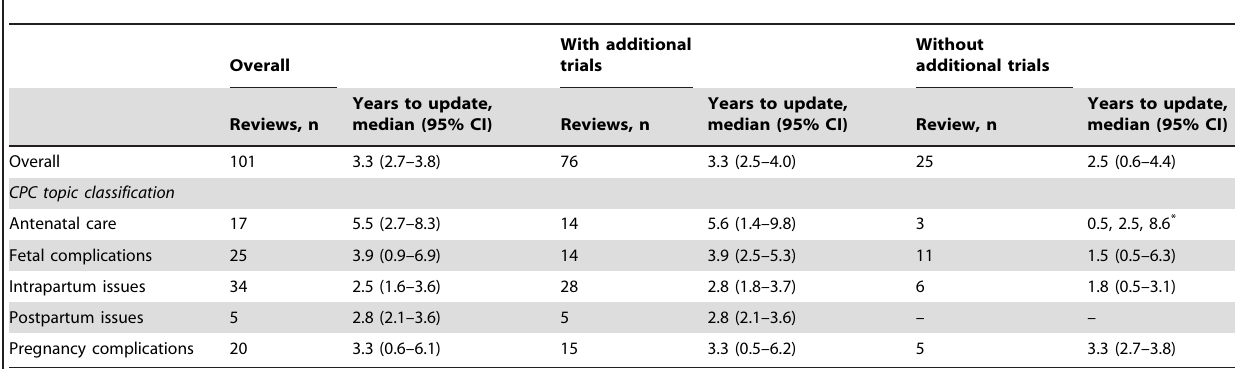
Table 2. Time to first update of the 101 updated reviews, by topic classification and presence or absence of additional trials.